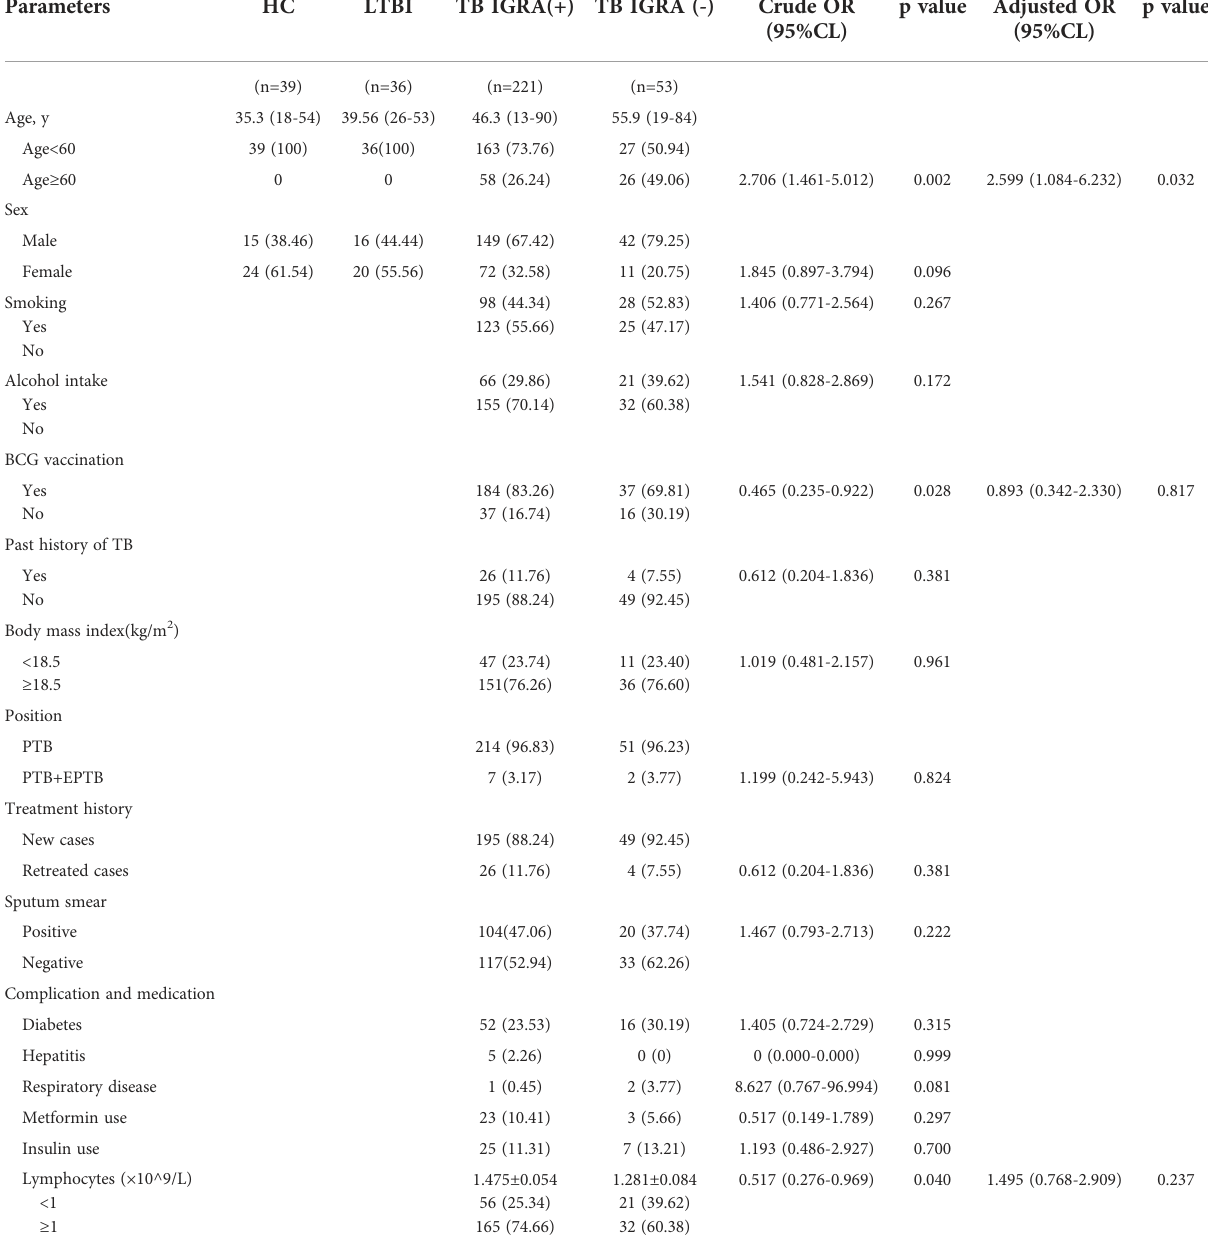
TABLE 1 Demographic characteristics of participants included in the fi nal